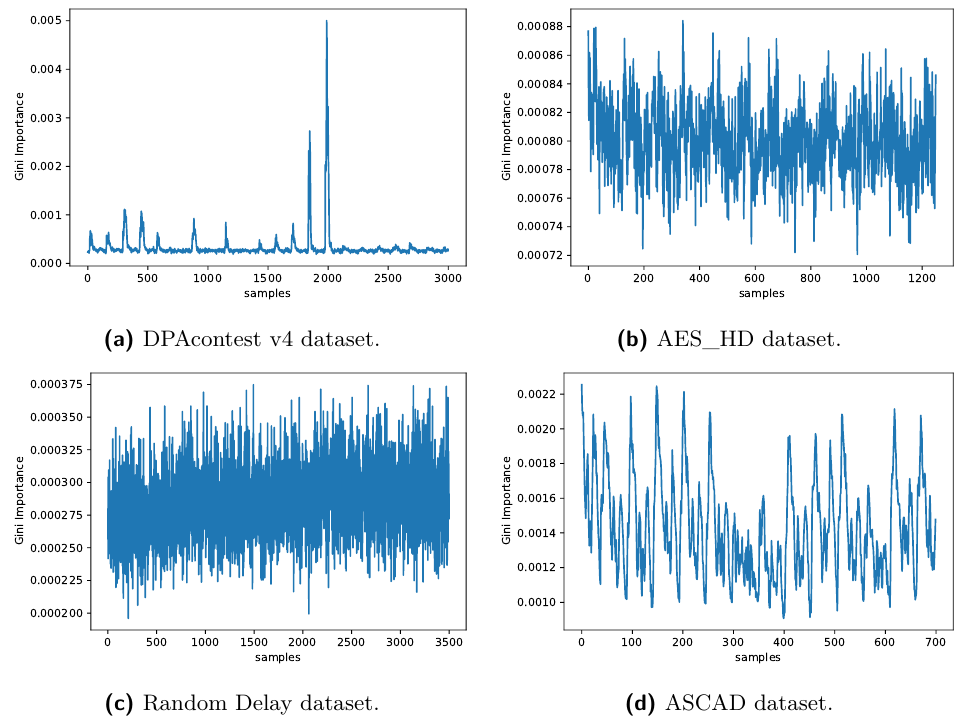
Figure 2: The feature importance derived from the Random Forest classifier. A higher value indicates corresponding feature dimension is relatively more important than the others. The values are normalized such that the sum of all the importance equals